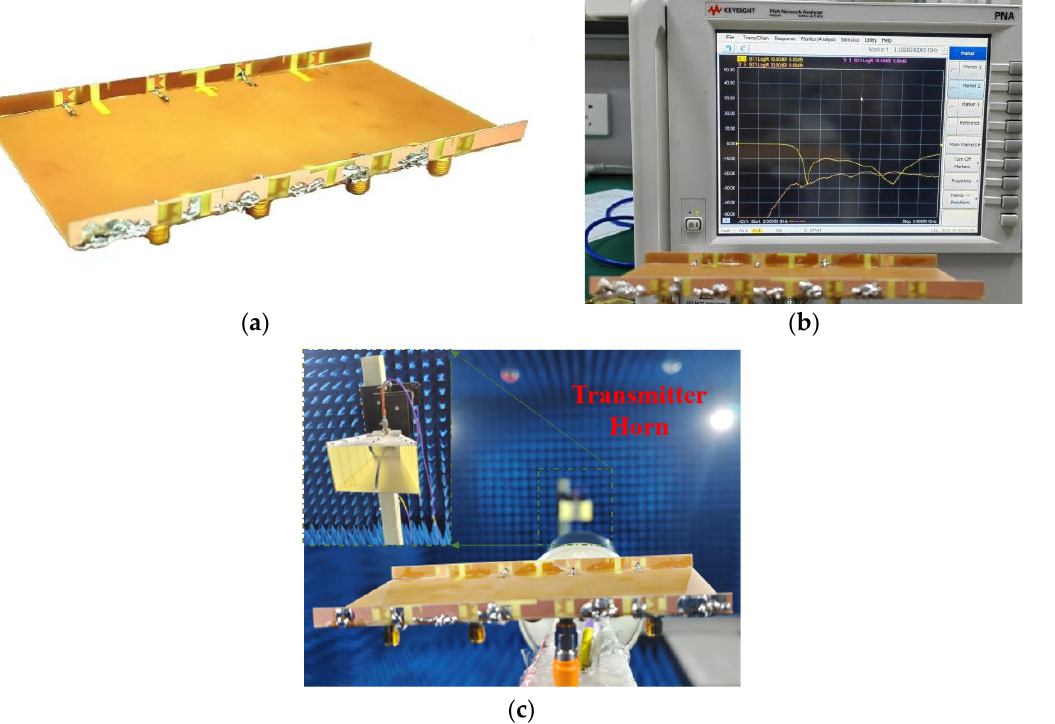
Figure 10. The portraiture of setup for measurements: ( a ) fabricated antenna; ( b ) vector network analyzer; ( c ) anechoic chamber.